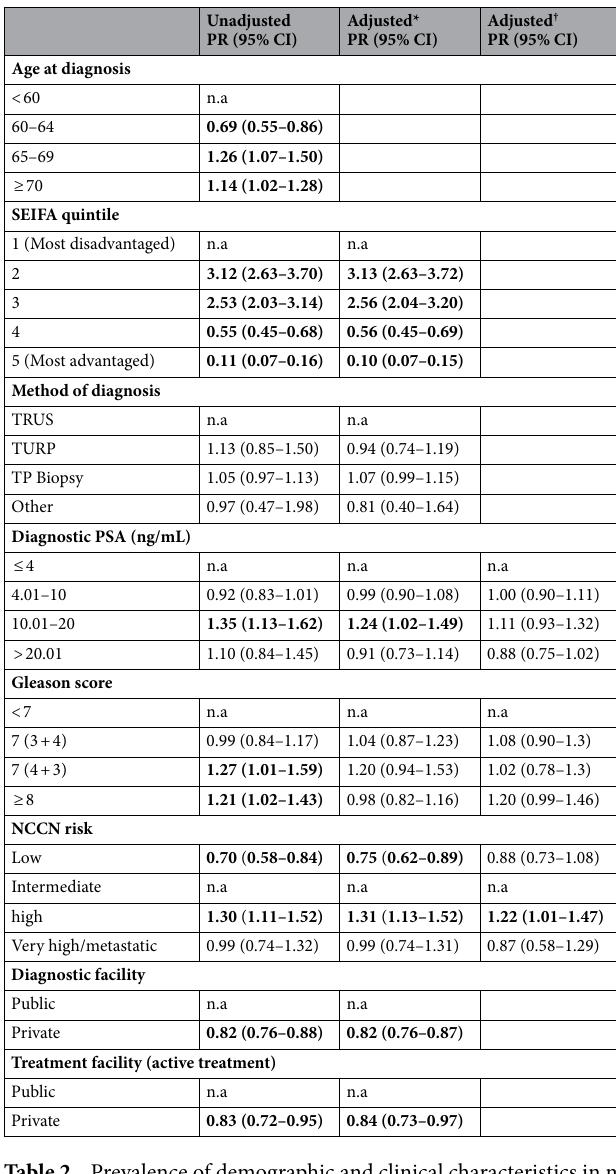
Table 2. Prevalence of demographic and clinical characteristics in men with prostate cancer living in outer regional/remote areas of Tasmania relative to their counterparts living in inner regional areas. PR = Prevalence Ratio; CI = Confidence Interval; n.a. = Not Applicable; SEIFA = Socio-Economic Index of Advantage and Disadvantage; TRUS = Transrectal Ultrasound; TURP = Transurethral Resection of the Prostate; TP Biopsy = Transperineal Biopsy; PSA = Prostate Specific Antigen; NCCN = National Comprehensive Cancer Network. *Adjusted for age at diagnosis. † Adjusted for age at diagnosis, SEIFA index, method of diagnosis and type of diagnostic